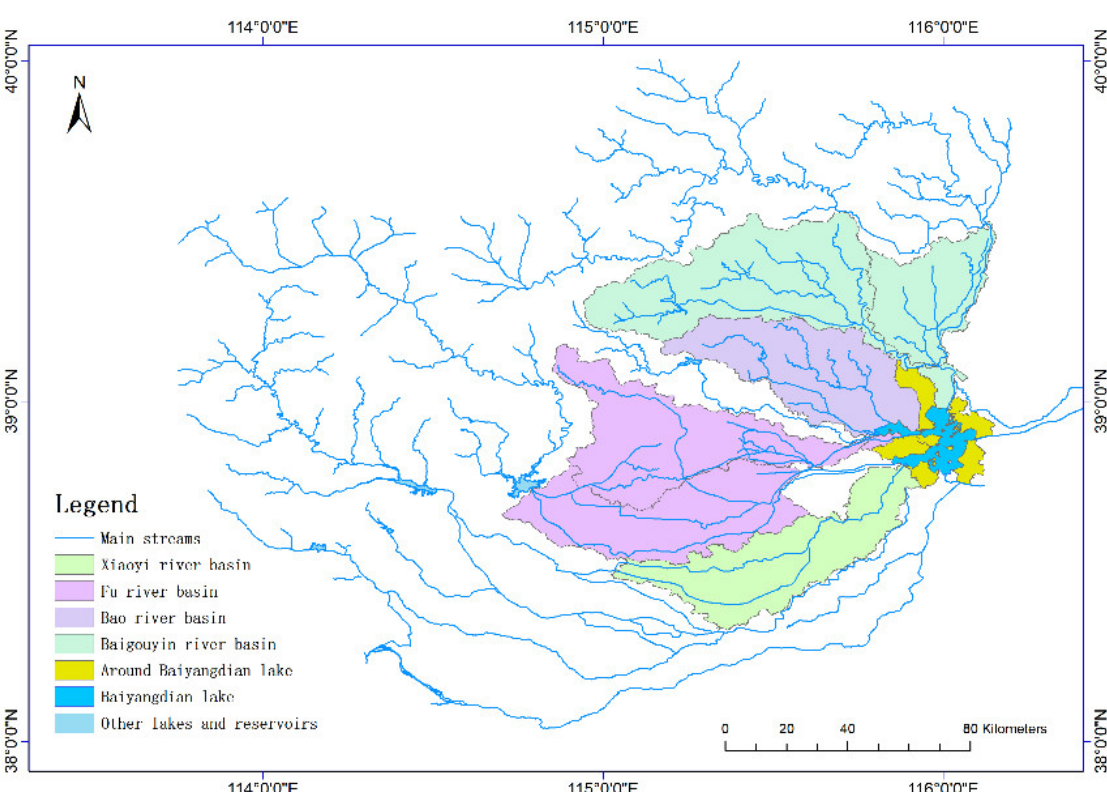
Figure 2. The sub-basin division of Baiyangdian lake basin.